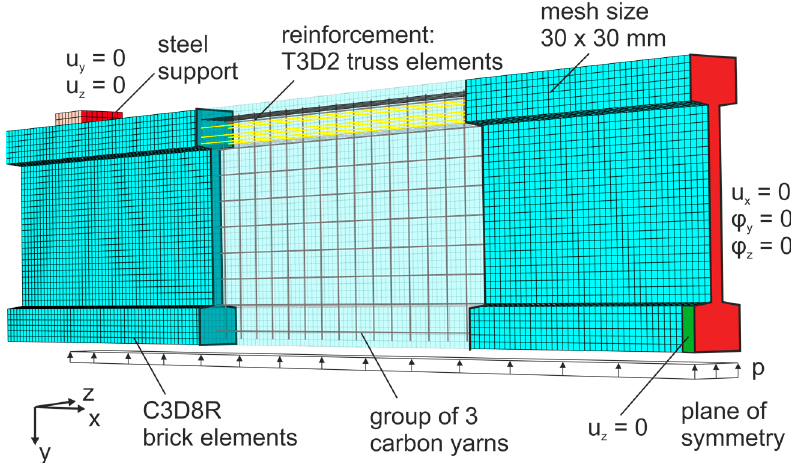
Figure 7. Schematic of input parameters and FE ‐ mesh for FT01 simulation in ABAQUS .